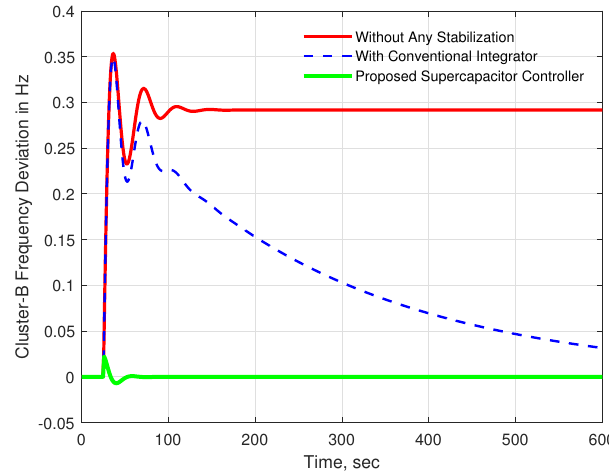
Figure 12. Frequency response for cluster B 0.01 p.u. disturbance in cluster B.